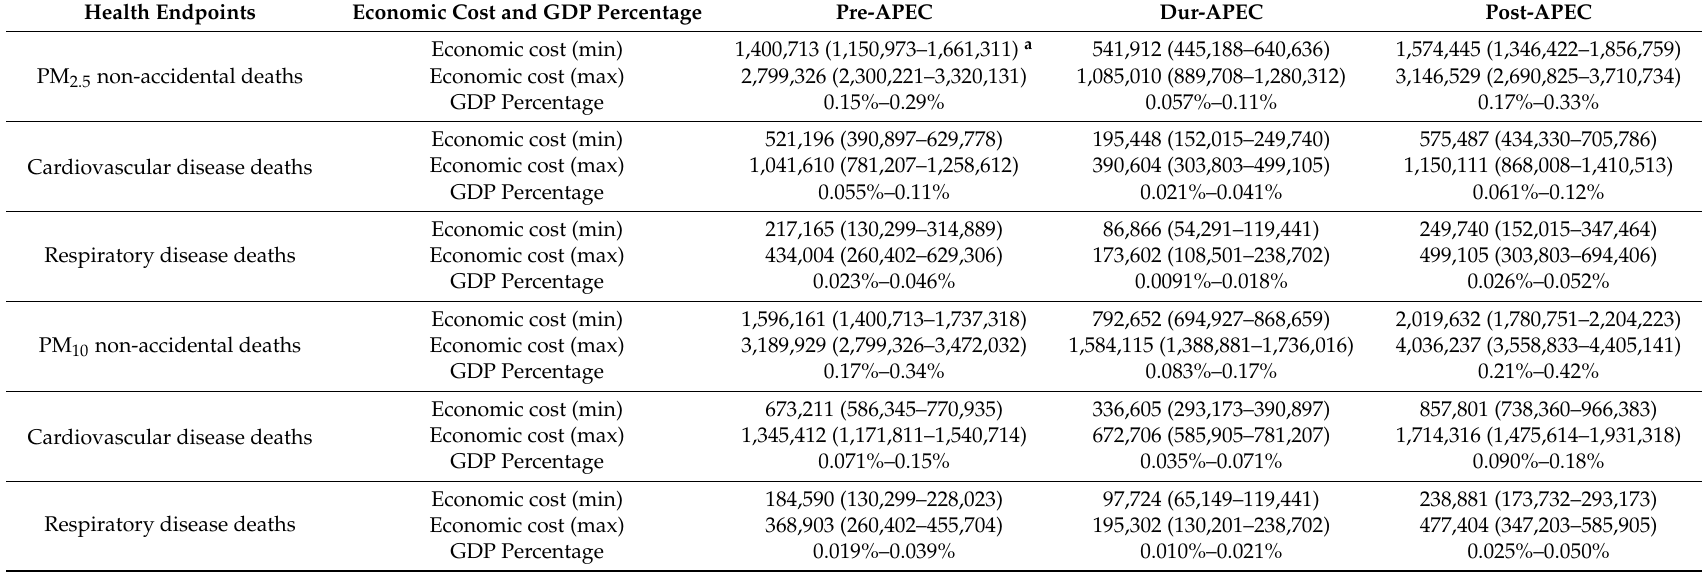
Table 4. Economic cost associated with PM health effects and the corresponding GDP percentage pre, during and post APEC (U.S.